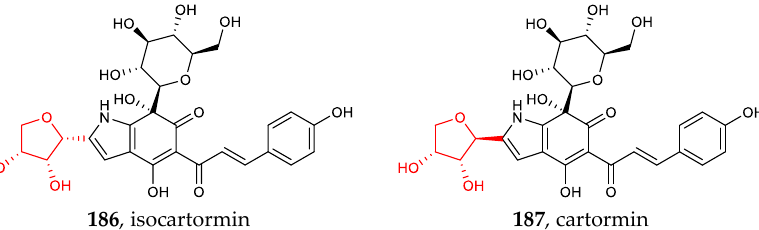
Figure 6. Chemical structures ( 170 – 187 ) of heteroaryl C -glycosides. 2.6. Other Aryl-C-Glycosides Other aryl- C -glycosides include aryl- C -glycosides of amino sugars and other rare sugars [30 – 36]. Compounds 190 – 197 (4-aminosugar) and compound 198 – 199 (3-aminosugar), which are 2-deoxylaminoglycoside antibiotics, resemble the well-known pluramycins. Among them, monacyclione G ( 190 ) possesses a unique scaffold featuring a xanthone core linked to the aminodeoxysugar ossamine, and monacycliones H − J ( 194 – 195 , 192 ) are rare examples of natural angucyclines with an S-methyl group (Figure 7).